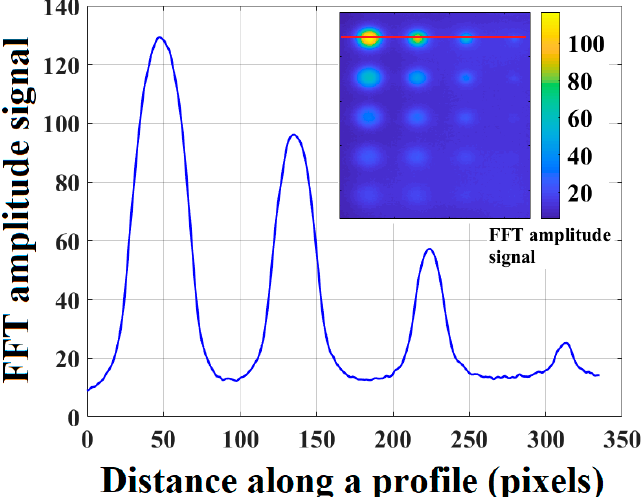
Figure 7. An example of the amplitude signal (PPT) along a profile in which are highlighted the peaks of the signal due to the first row of defects; (0.3906 Hz with 512 analyzed frames).